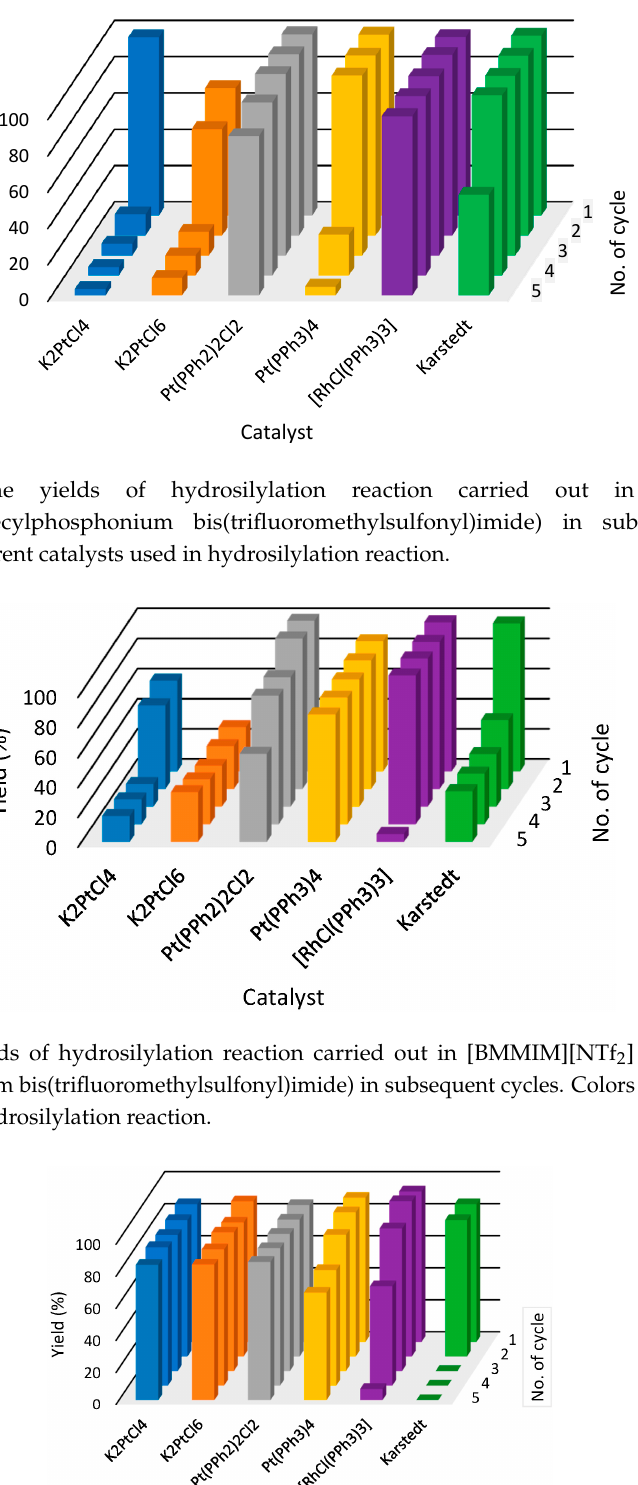
Figure 5. The yields of hydrosilylation reaction carried out in [S 222 ](NTf 2 ) ( 4 ) (triethylsulfonium bis(trifluoromethylsulfonyl)imide) in subsequent cycles. Colors refer to different catalysts used in hydrosilylation reaction.